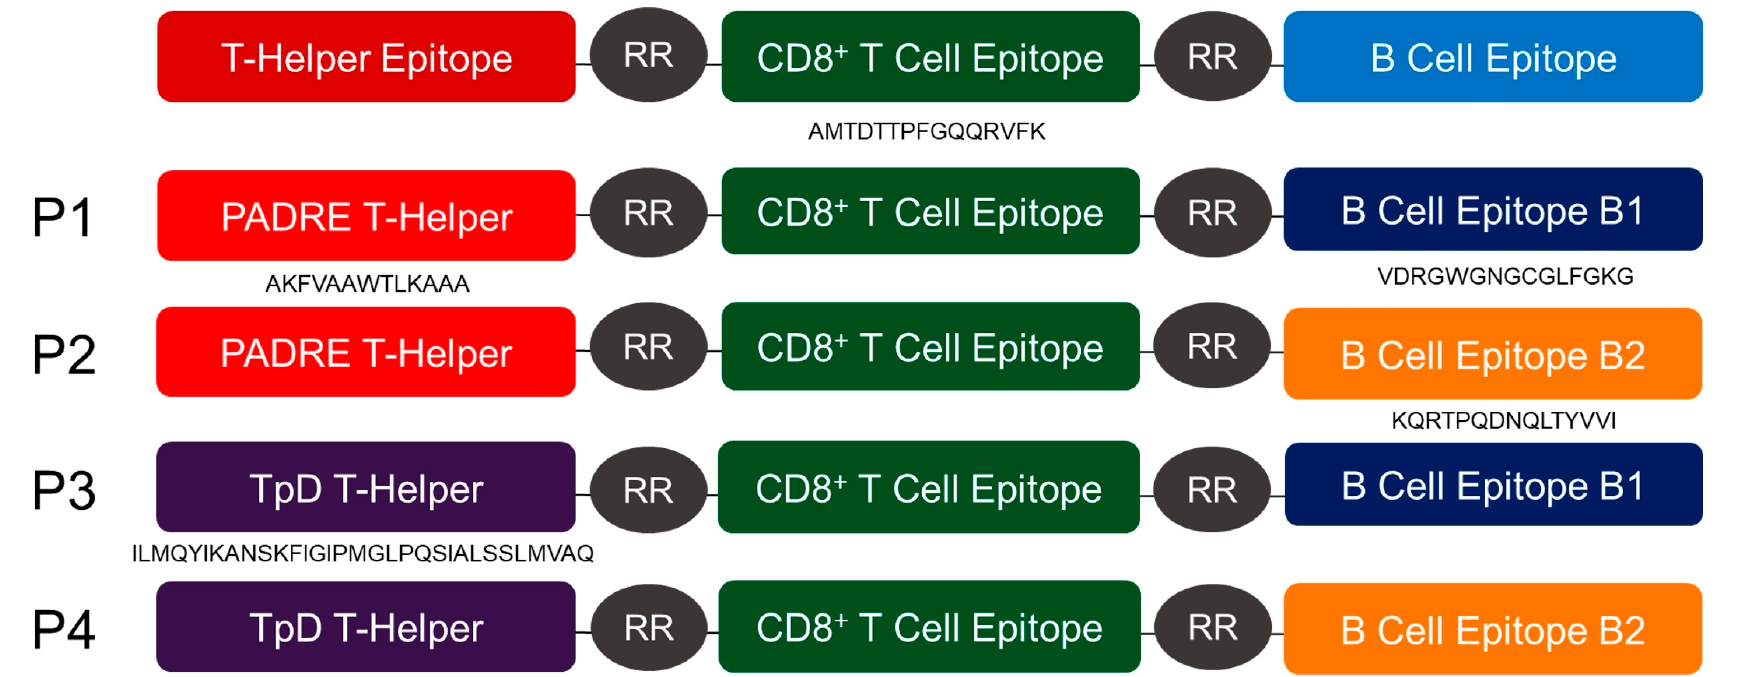
Figure 1. A schematic diagram of the four peptide constructs (P1–P4).